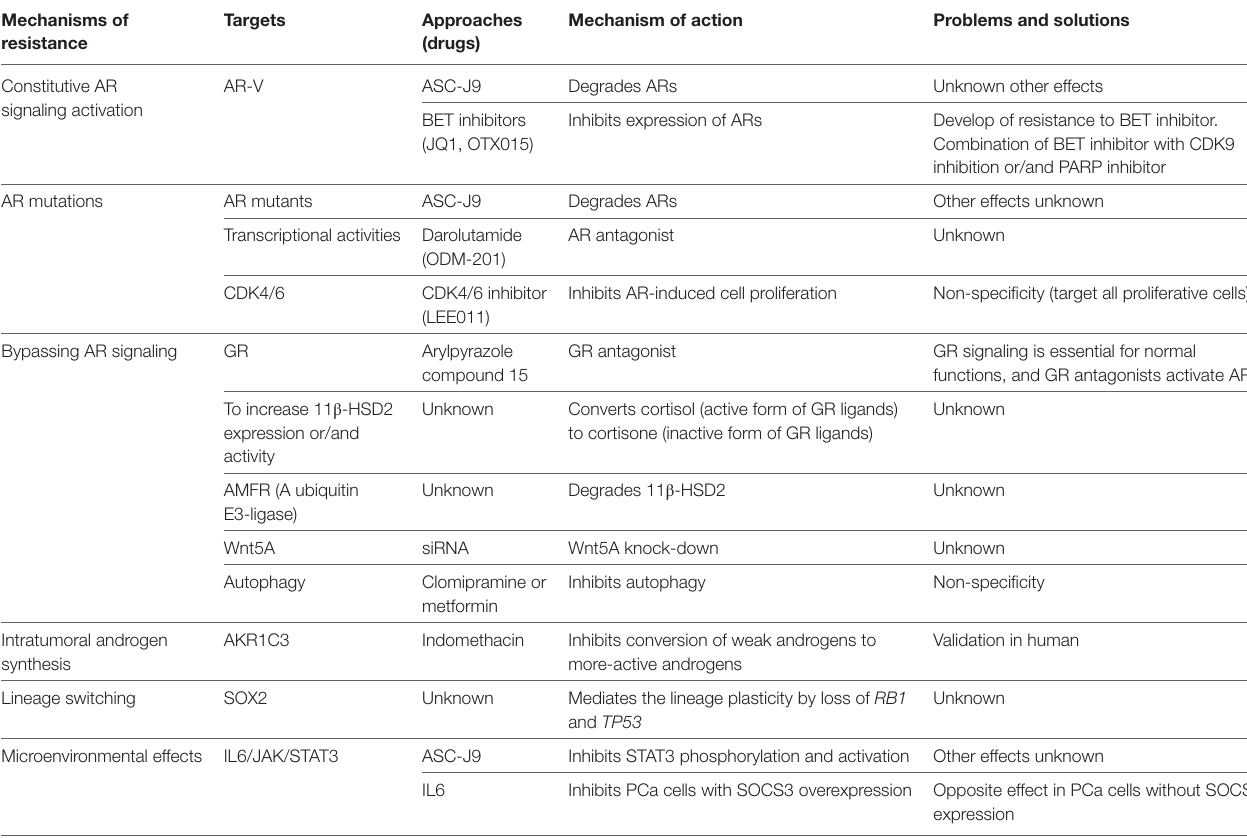
TABLe 1 | Summary of mechanisms and approaches of overcoming the enzalutamide resistance in preclinical PCa model. Mechanisms of